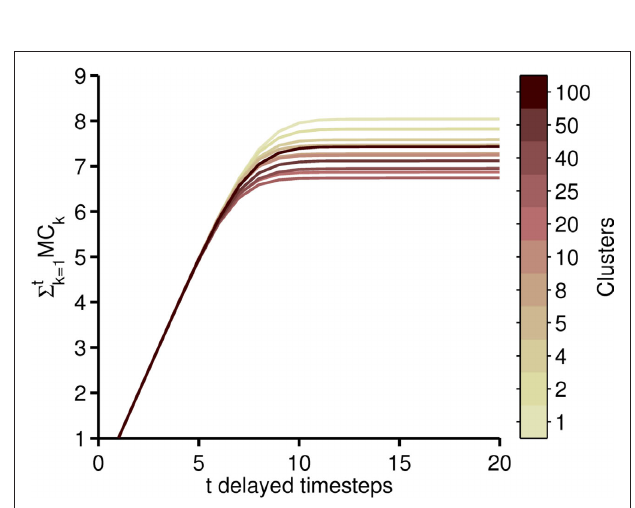
Figure 8 | ∑ = kt k MC 1 was calculated for a collection of clustered reservoirs with total reservoir size R = 200 and for delay t ranging from 1 to 20